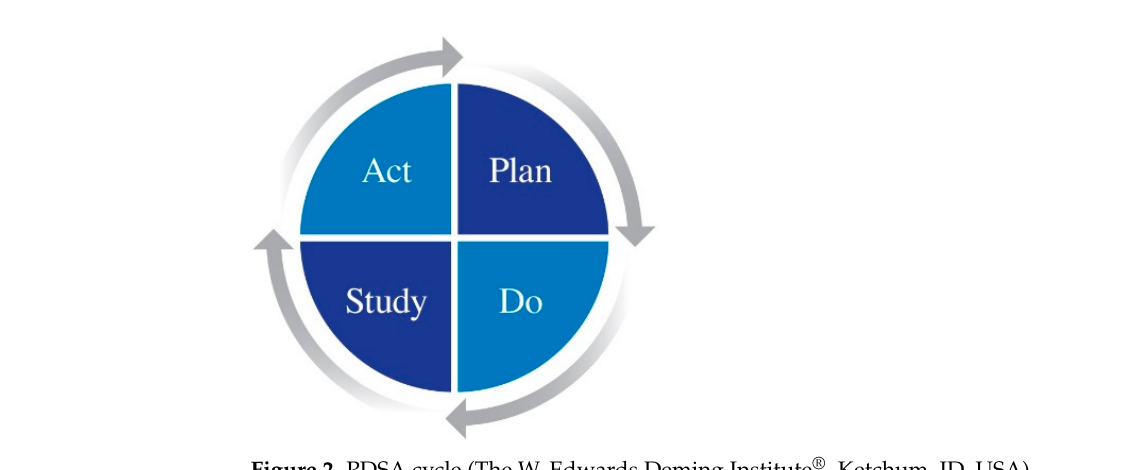
Table 1. Quality improvement project: a stepwise